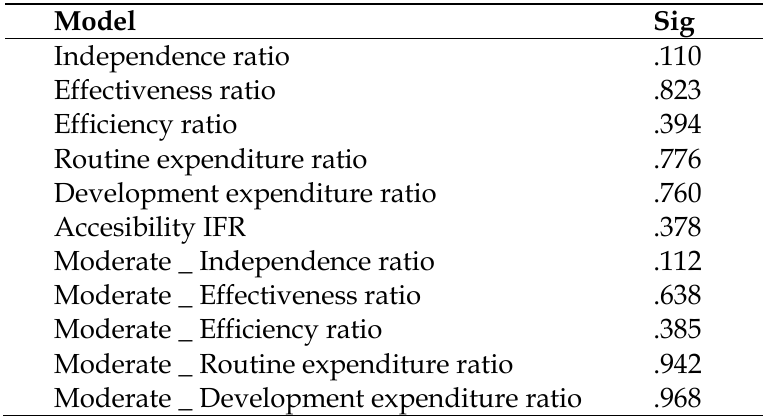
Figure 2: Test Result of P-Plot Heterocedasticity test is used to find out whether in the regression model there is an inequality of variance from one residual observation to another. The Glejser test results in table 3 show that the significance values in the variables in this research are greater than 0.05. With this 5% confidence level, it can be concluded that the regression model in this research does not contain heterocedastic- ity. Table 3. Heteroscedasticity Test Results (Glejser Test)